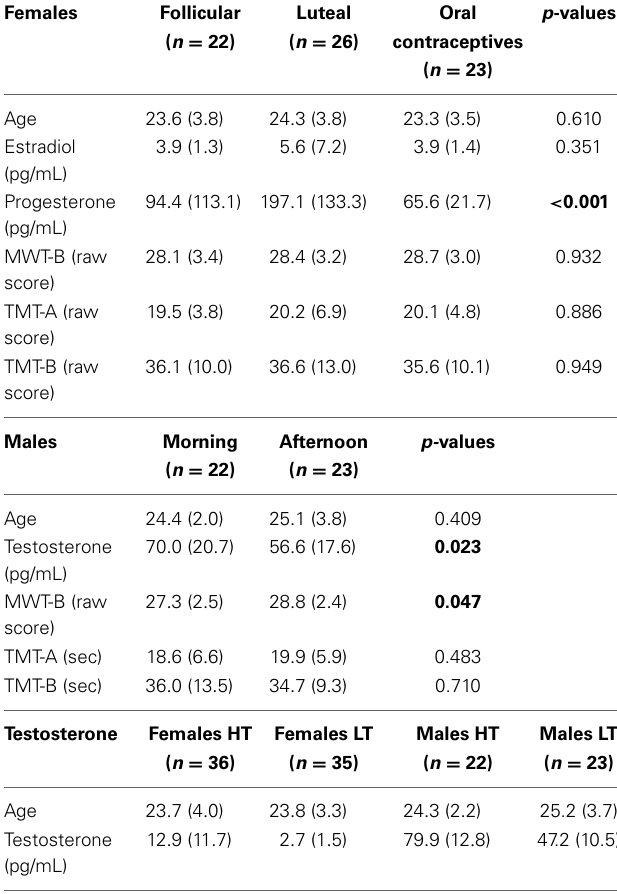
Table 1 | Description of groups including sociodemographic, hormonal, and neuropsychological means (standard deviations in parentheses) and p